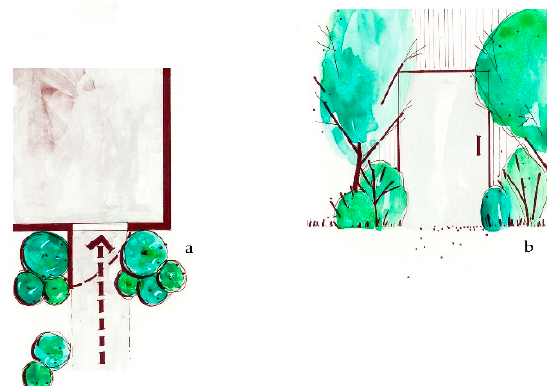
Figure 3. The Plant entrances intervention considers the amount of planted landscape at building or site entrances or exterior doorways, which may include trees or other vegetation. ( a ) Plan view of building entrance; ( b ) Sketch elevation of potential green entrance.